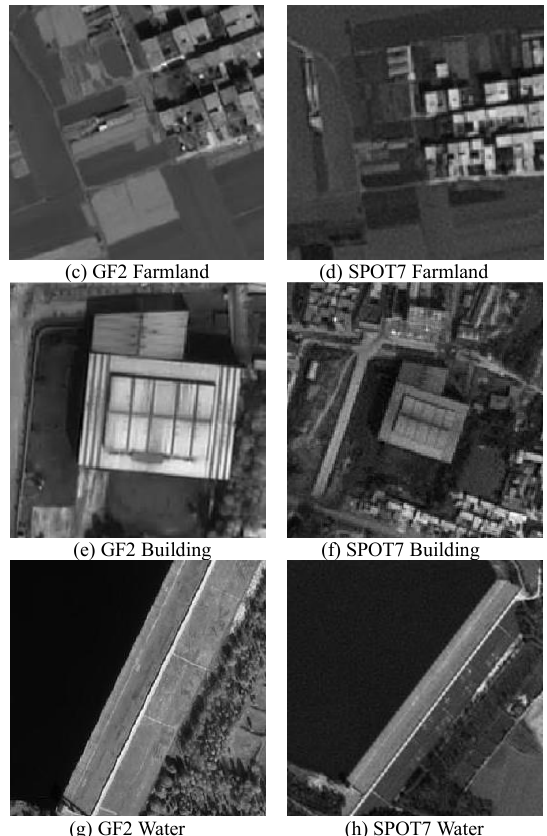
Figure 6. Image patches of GF2 and SPOT7 at the same place Since the resolutions of GF2 and SPOT7 are different, the GSD factor needs to be taken into account. Nine features were extracted from the image patches and put into fuzzy comprehensive evaluation function. With different feature weights, the evaluation results